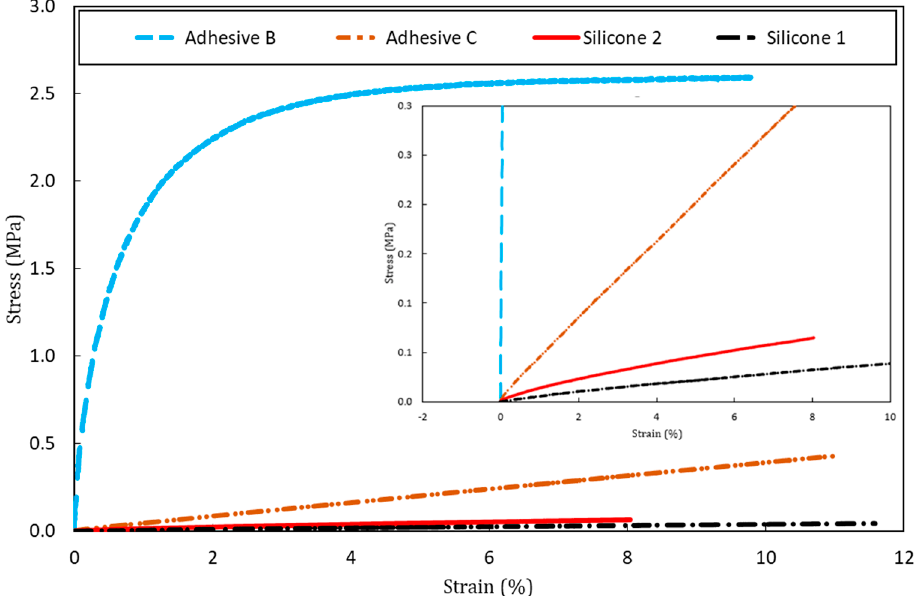
Figure 6. Experimental stress / strain curves collected from samples of the various adhesives subjected to tensile tests.